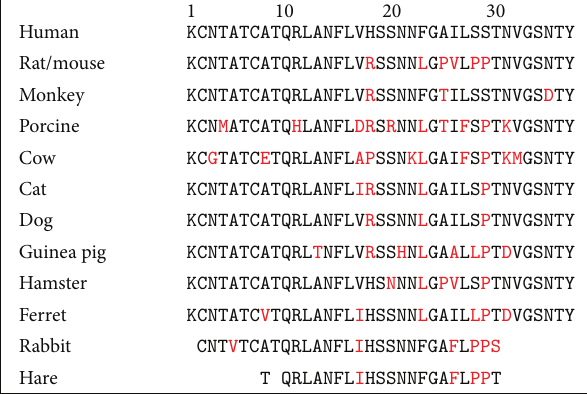
Figure 4: Primary sequence of IAPP from different species. Only partial sequences are available for rabbit and hare. Residues that differ from the human IAPP sequences are highlighted in